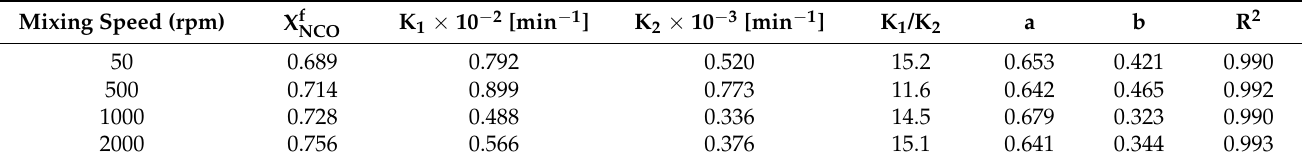
Table 5. Effects of mixing speed on NCO conversion: results of the fitting procedure.